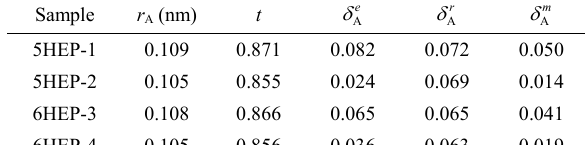
r δ ), and atomic A m δ ) of HEP RETa 3 O 9 ceramics A